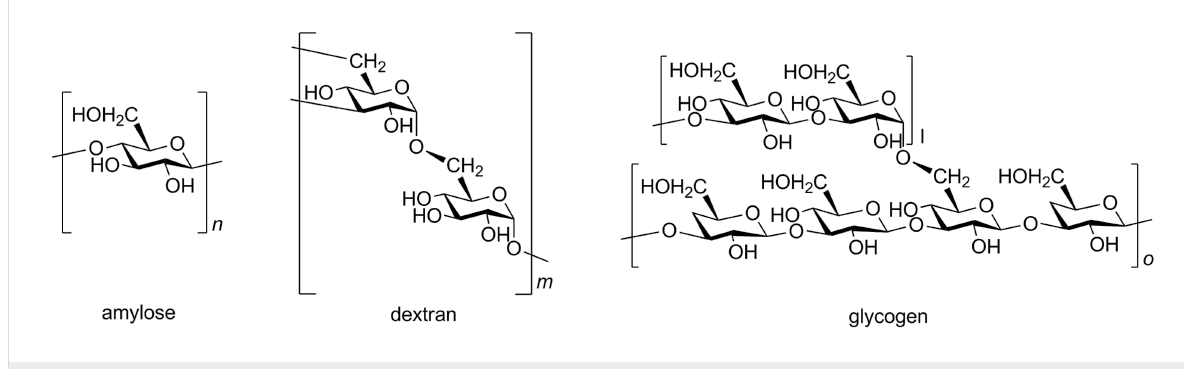
Figure 2: Schematic structure of amylose, dextran and glycogen.